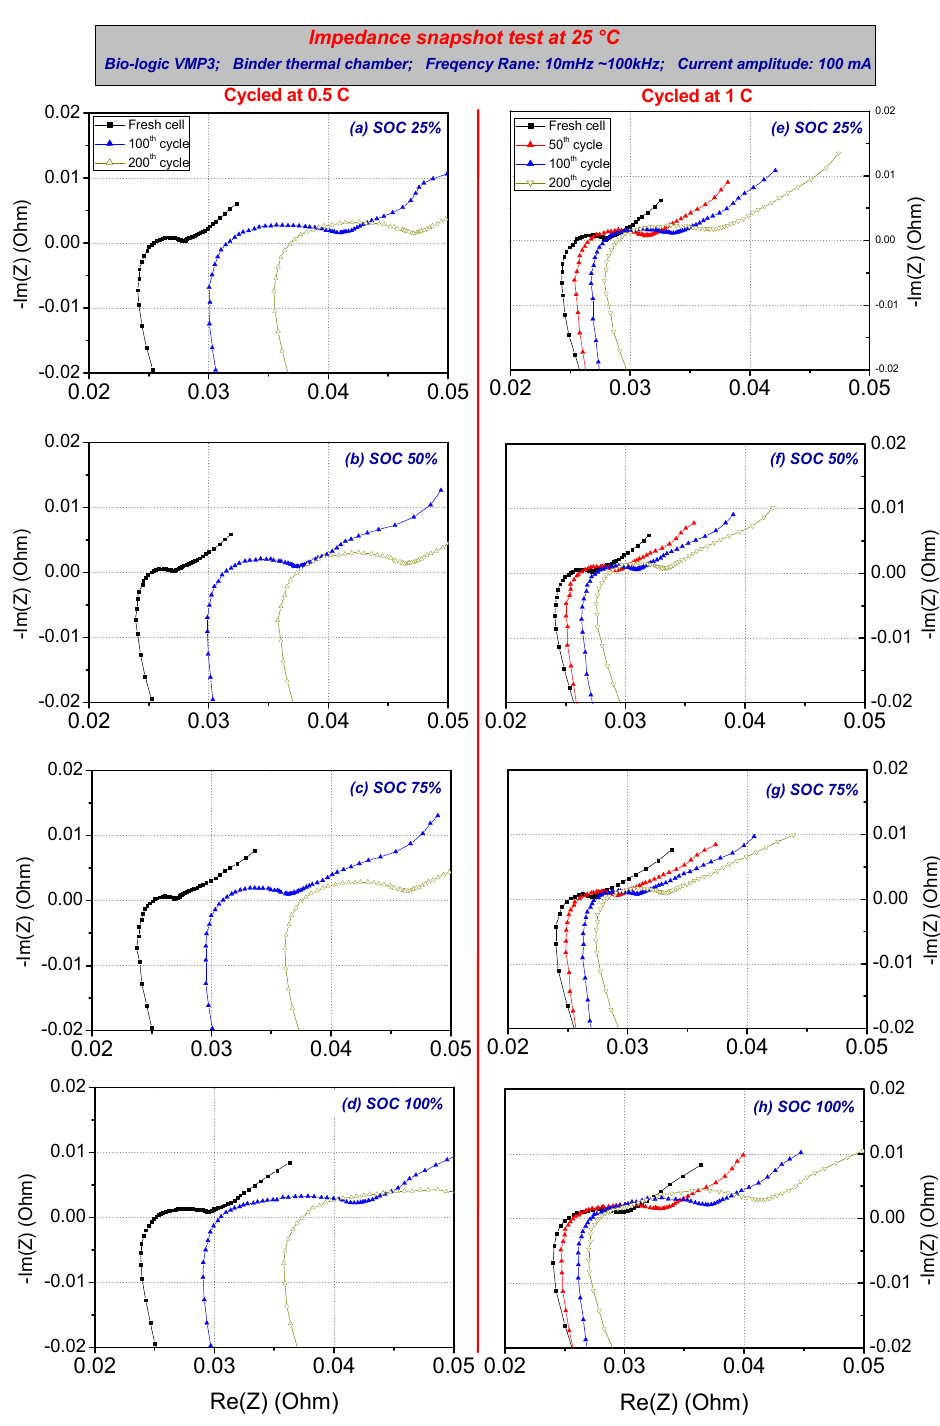
Figure A3. Impedance snapshot at various SOCs for batteries experienced 0 °C cold ageing.